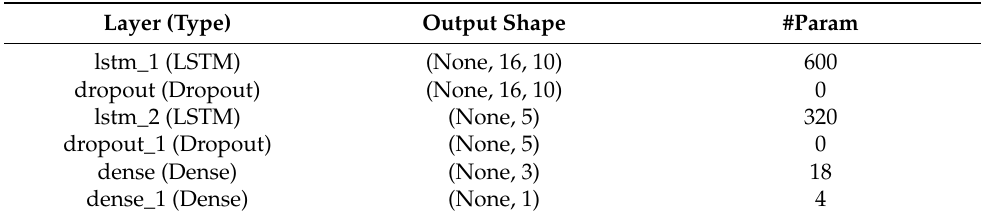
Table 2. RNN model Table 2. RNN model details.